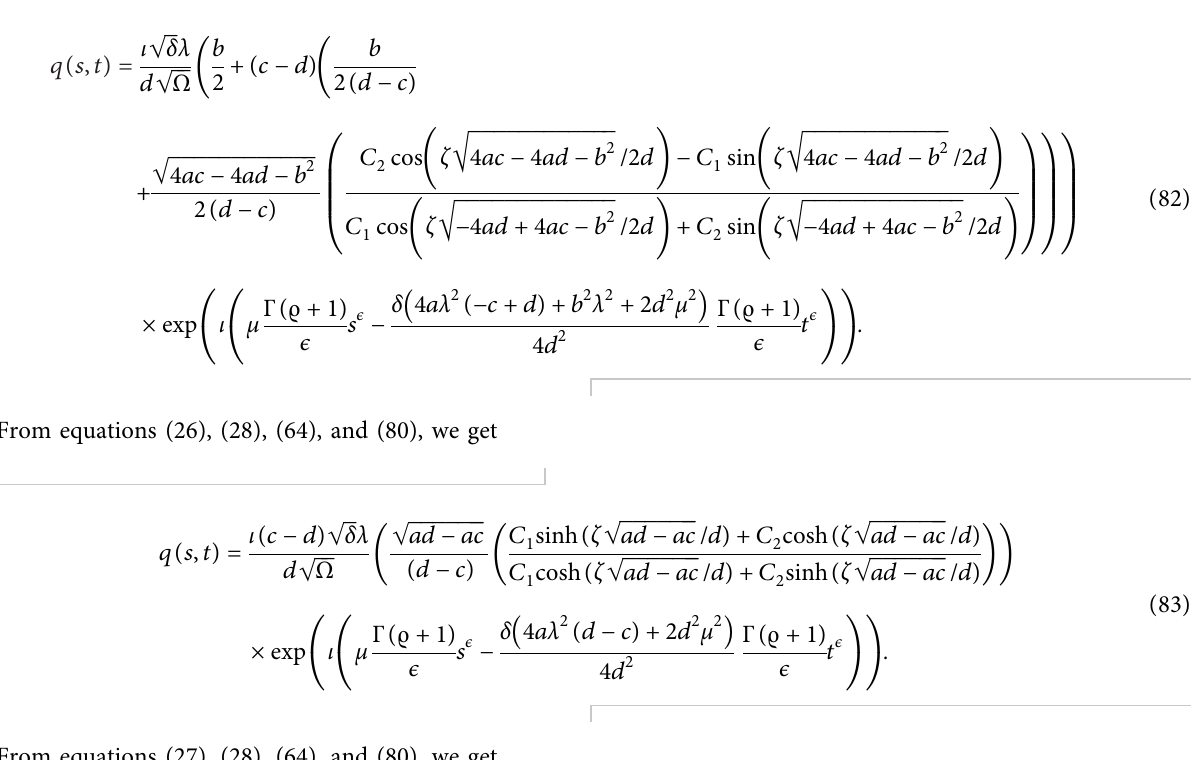
� 0 . 1 , β � 0 . 1 , d � 0 . 1 , ϵ � 0 1